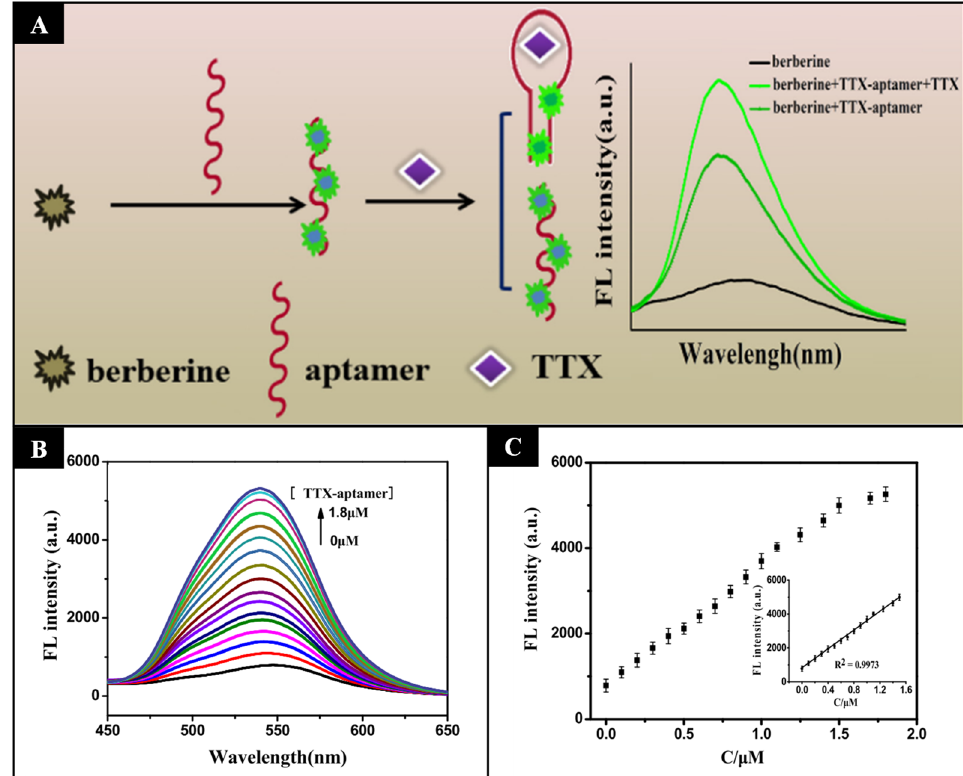
Figure 3. ( A ) Schematic representation of tetrodotoxin detection by a fluorescent method dependent of the aptamer conformational change. ( B ) Fluorescent spectra obtained with different concentrations of tetrodotoxin and ( C ) calibration curve. (Reproduced with permission [95], Copyright 2019, Elsevier).